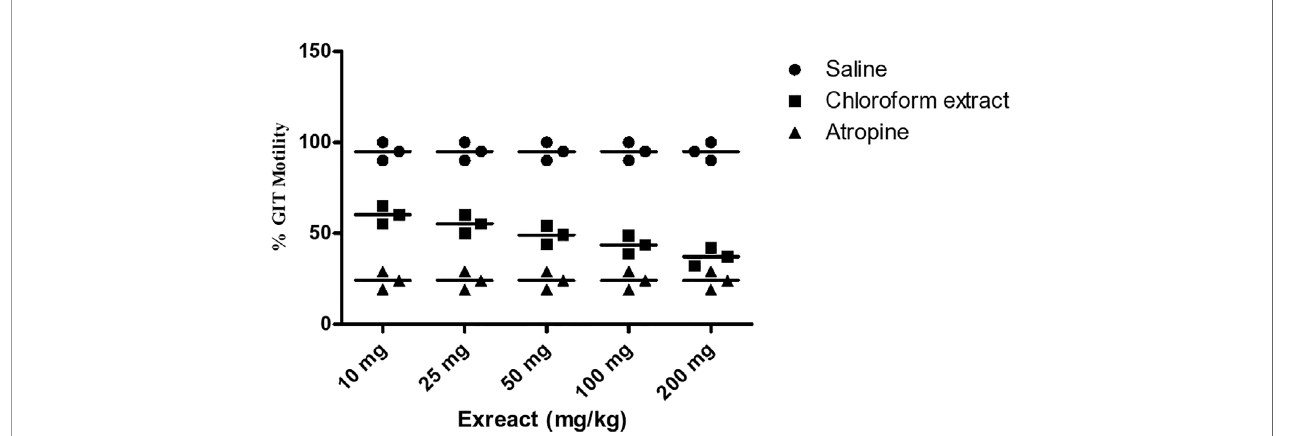
FIGURE 2 | Bar diagram indicated the GIT motility pro fi le of chloroform extract in a dose-dependent manner of charcoal meals through small intestine of